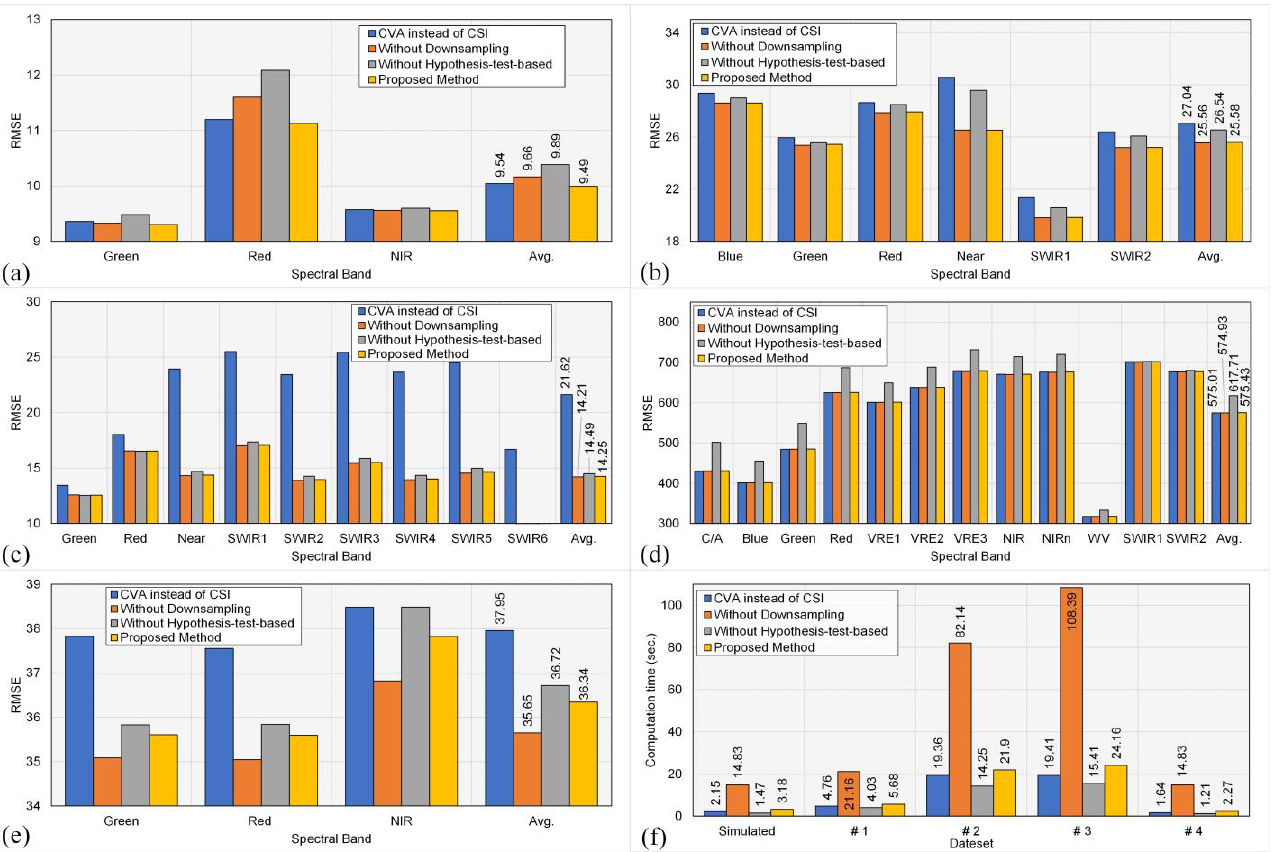
Figure 5. The RRN performance resulted from the proposed coarse-to-fine PIF selection and the same strategy without down-sampling, without hypothesis-test-based, and when CVA was used instead of the CSI for the simulated dataset ( a ) and datasets 1 – 4 ( b – e ) and ( f ) their processing time. It is evident from bar charts Figure 5a – e that using CVA instead of CIS index in the proposed coarse-to-fine PIFs selection resulted in a significant reduction in RRN perfor- mance for most analyzed datasets. For example, the average RMSE was reduced by 7.37 and 0.05 in the best (simulated dataset) and worst (dataset 2) cases after using CVA instead